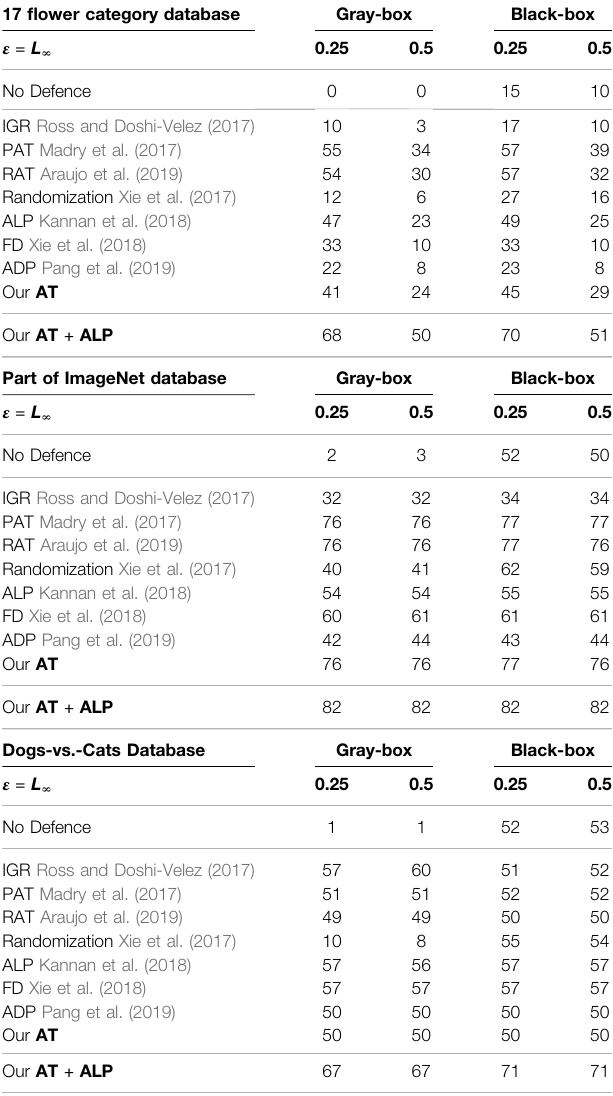
TABLE 2 | Defense against gray-box and black-box attacks on 17 Flower Category Database, Part of ImageNet Database and Dogs-vs.-Cats Database.TheadversarialperturbationwereproducedusingPGDwithstepsize α (cid:1) 1.0/256 (cid:1) 0.0039 and 200 attack iterations. As shown in this table, AT + ALP got the highest Top-1 Accuracy on all these database